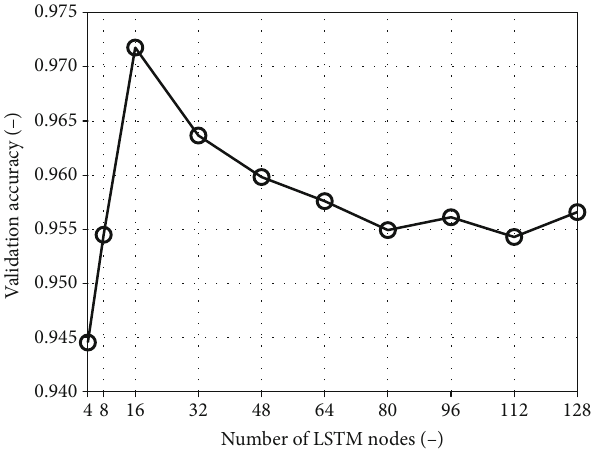
Figure 9: Training outcomes of DNN-C48 and other descendant architectures; horizontal axis indicates the number of nodes enclosed in the LSTM branches.